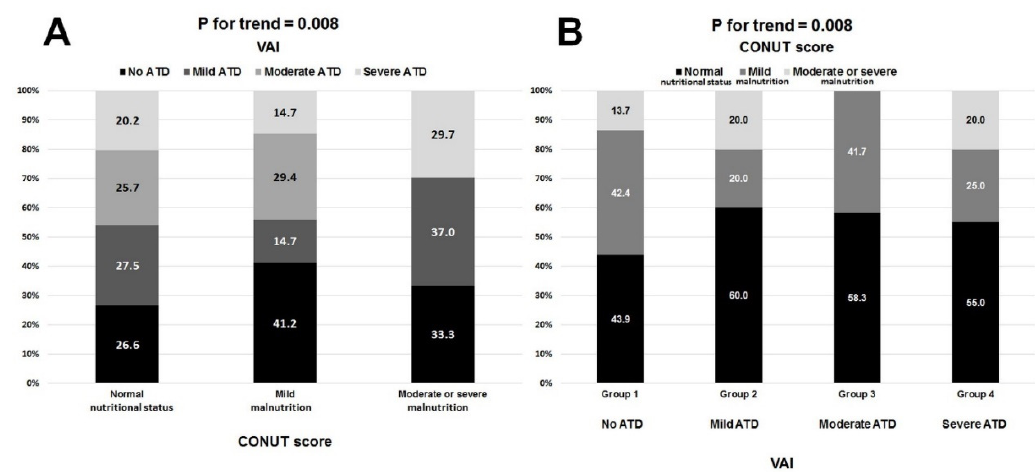
Figure 4. The distribution of VAI-defined adipose tissue dysfunction (ATD) types in respective BMI-defined ( A ) and BAI- defined ( B ) weight categories.